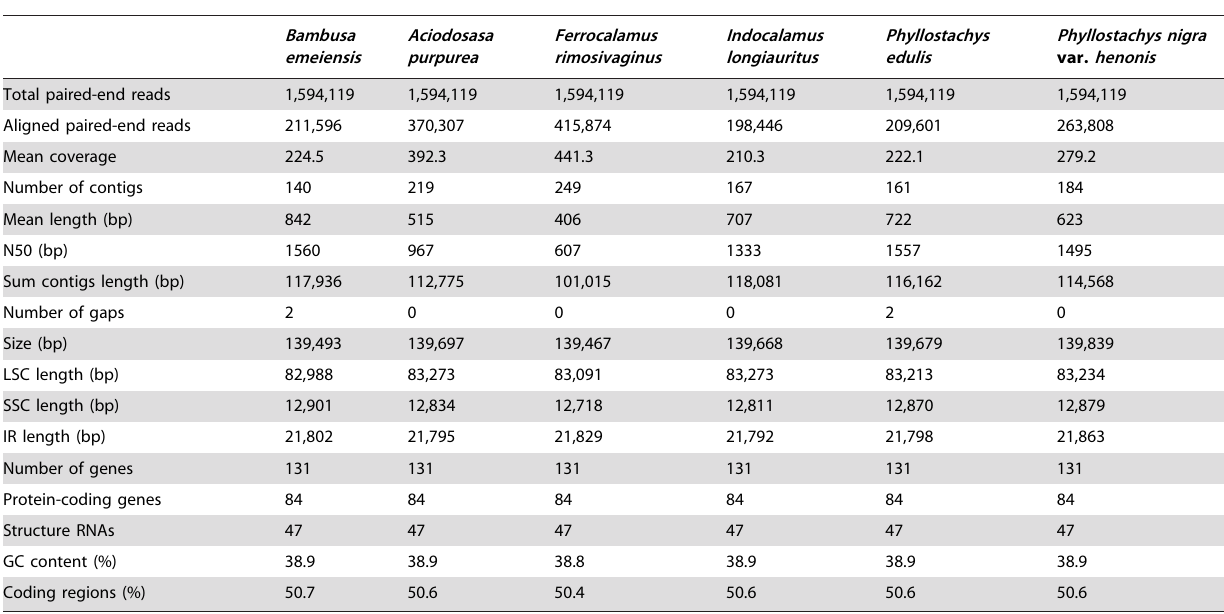
Table 1. Summary of the chloroplast genome sequencing, assembly and